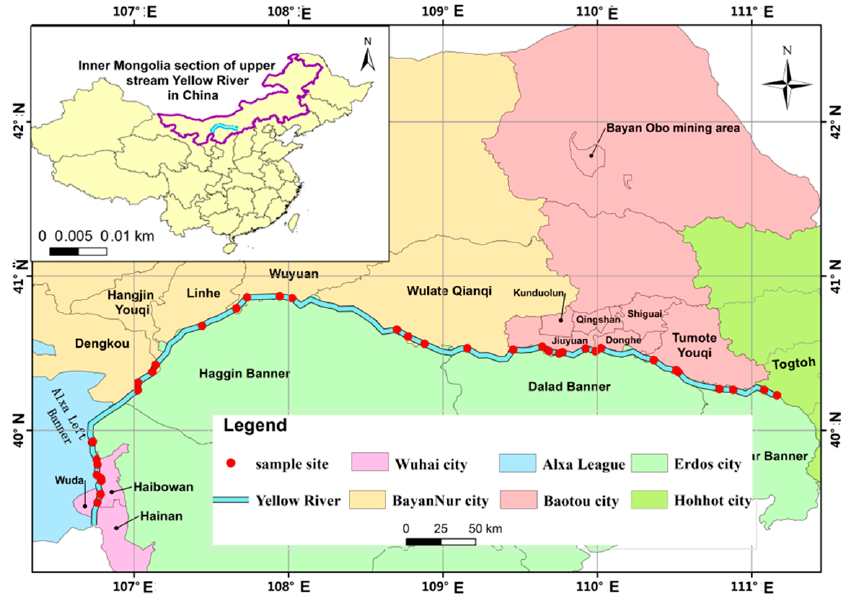
Figure 1. Spatial distribution of sampling sites in sediments from Inner Mongolia section of Yellow River.